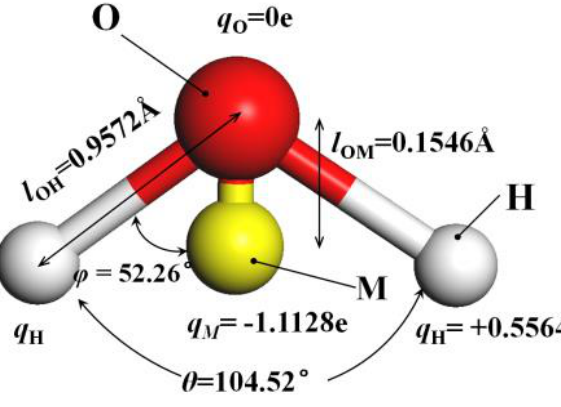
Figure 3. The model of TIP4P/2005 water molecular.